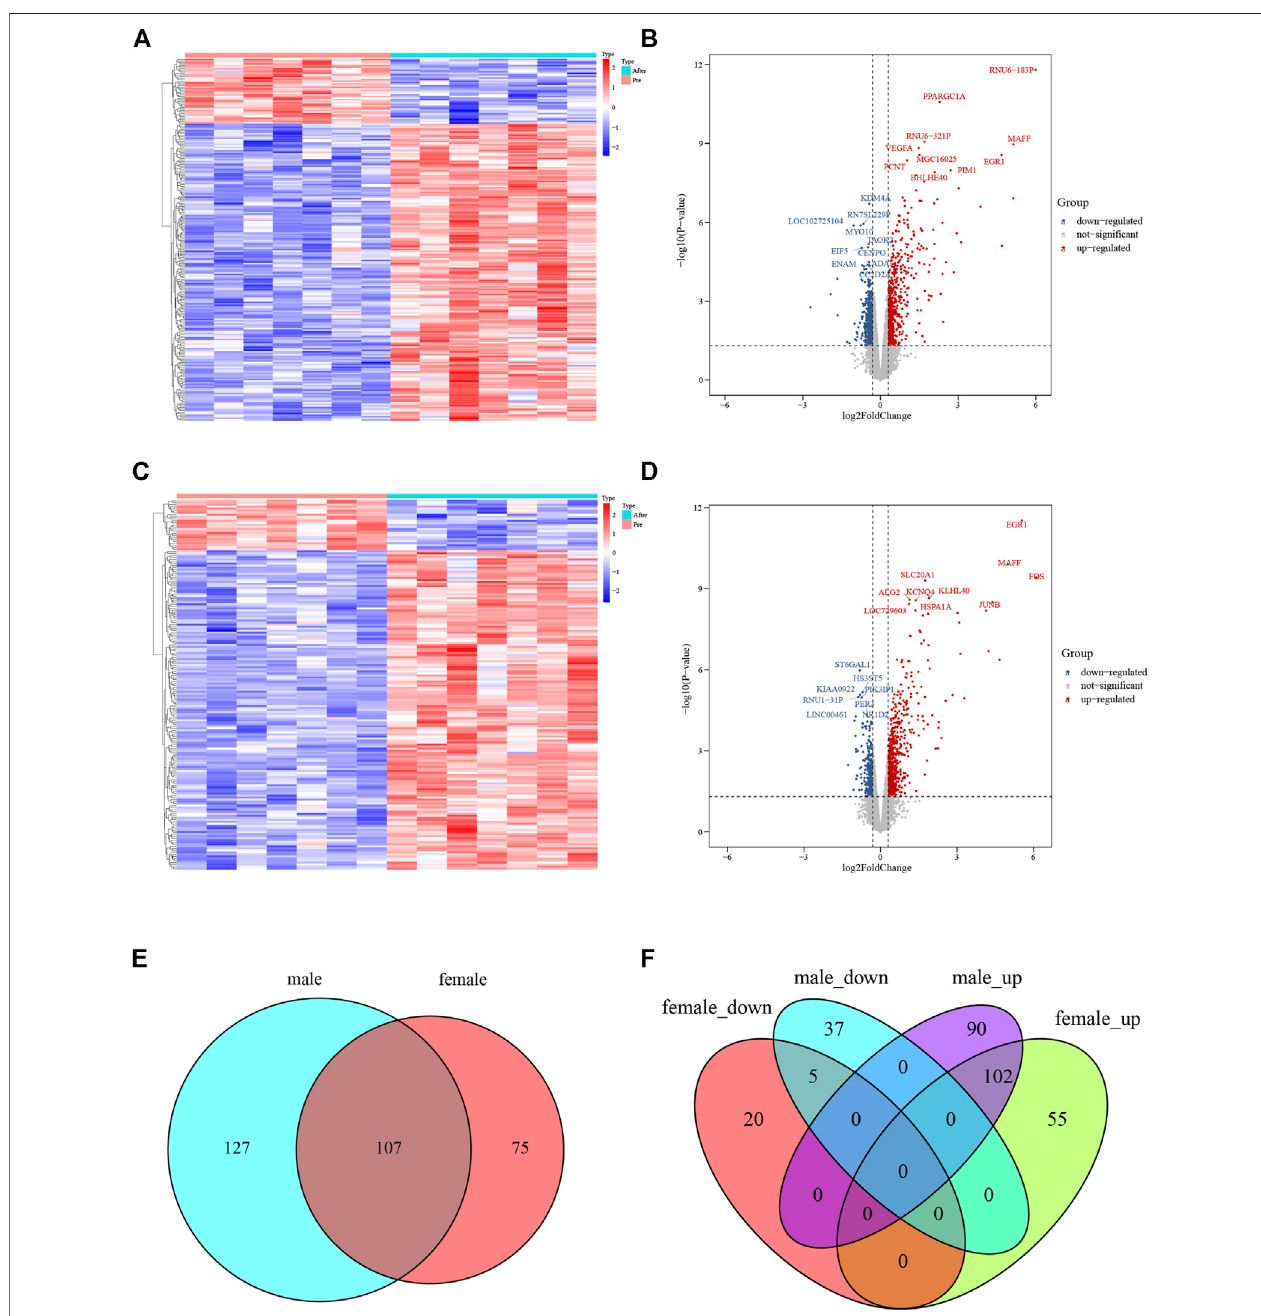
FIGURE 2 | Analysis of differentially expressed genes in response to acute sprint exercise in skeletal muscle from men and women. (A) Heat map of 234 differentially expressed genes in muscle from men. (B) Volcano plot of 234 differentially expressed genes in muscle from men. (C) Heat map of 182 differentially expressed genes in muscle from women. (D) Volcano plot of 182 differentially expressed genes in muscle from women. (E) Venn diagram showing the overlap of differentially expressed genes between men and women. (F) Venn diagrams showing the overlap of the differentially expressed genes that were upregulated and downregulated in men and women. Red dots represent upregulated genes, and blue dots indicate downregulated genes. FC, fold change.